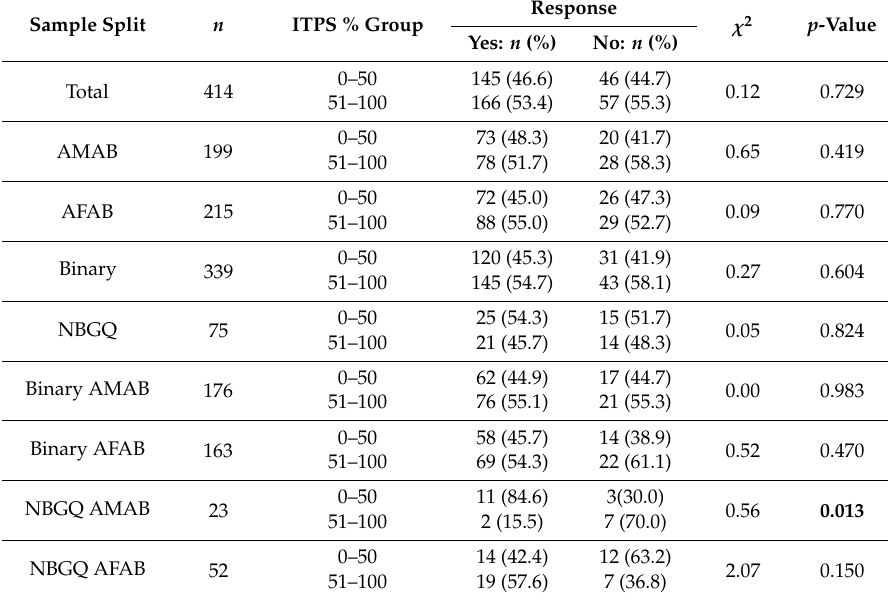
Table 4. Results of the chi-square tests of homogeneity / Fisher’s exact test for variable ‘desire for